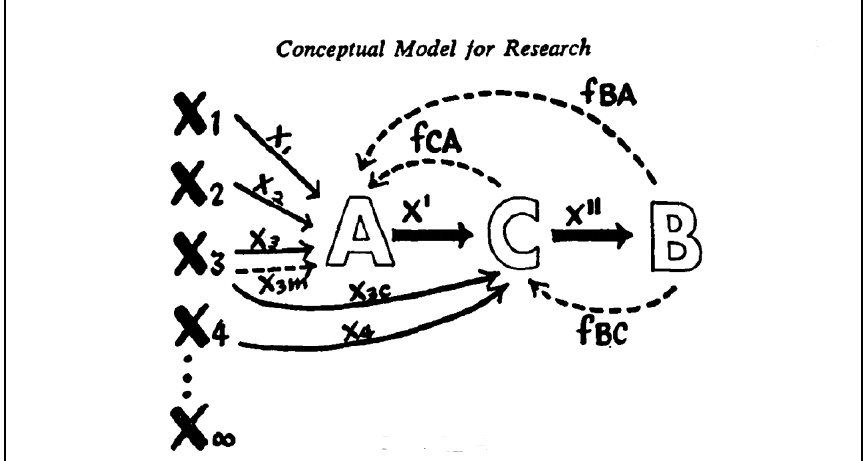
Figure 1: Westley and MacLean’s 1957: